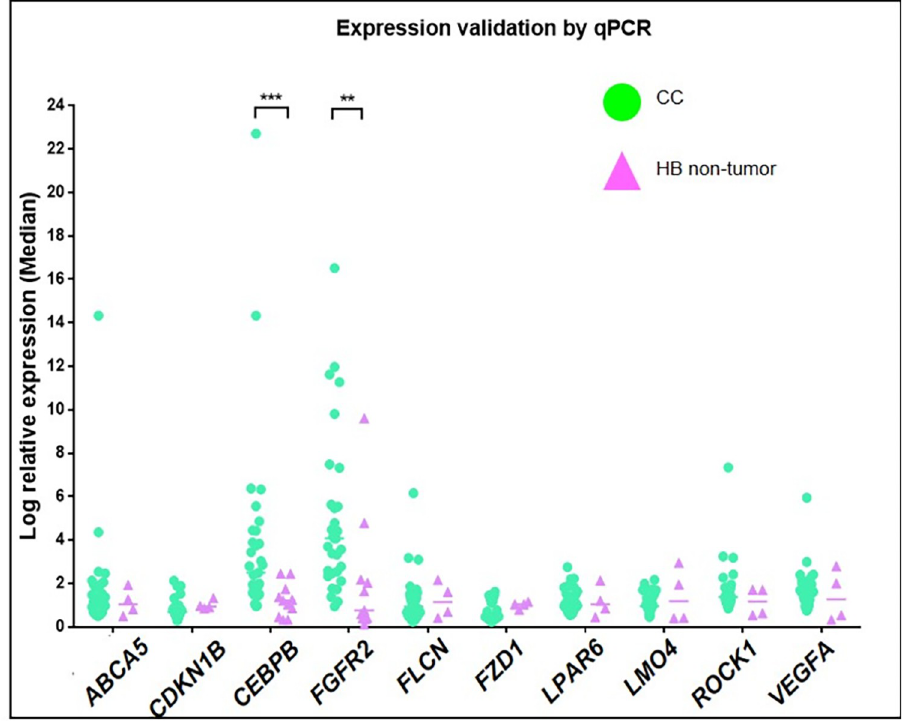
Fig 2. Elevated FGFR2 and CEBPB expression in CC livers. Reverse transcription real-time quantitative polymerase reaction (RT-qPCR) validation of the DE genes in CC and HB livers. Total RNA was extracted from CC livers (n = 31) and HB non-tumor liver region (n = 11). Relative expression levels of the DE genes were determined using GAPDH as an internal reference and the 2 – ΔΔ Ct method. ** , p < 0.01. https://doi.org/10.1371/journal.pone.0283737.g002 (BD) (LP+ve; BD+ve), or only at the liver parenchyma (LP+ve; BD-ve), or undetected (LP-ve; BD-ve) in CC livers (Fig 3). In HB non-tumor and tumor regions, similar level of expression of CEBPB and FGFR2 were localized at the liver parenchyma. In contrast, bile duct expression